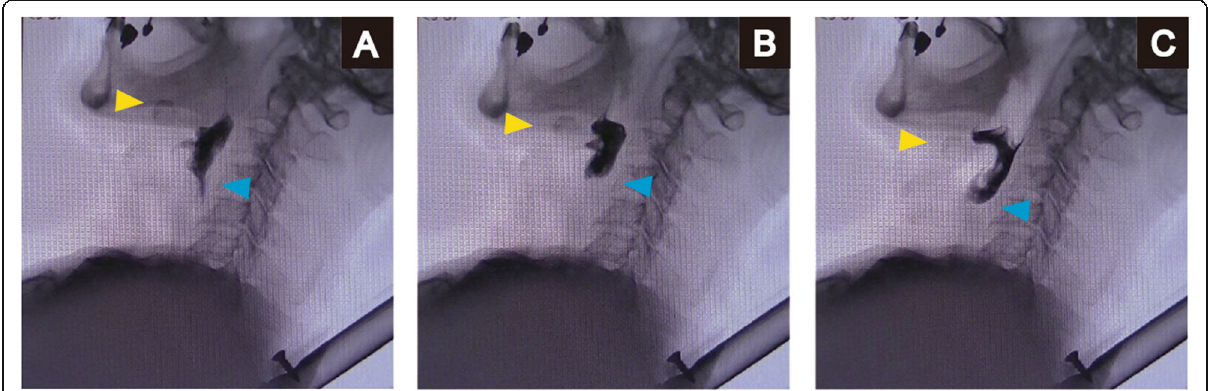
Fig. 2 Swallow functional test before cricopharyngeal myotomy. a Laryngeal penetration occurred during laryngeal elevation in the pharyngeal phase. b The bolus did not pass entirely through the upper esophageal sphincter in the esophageal phase. c Breathing was reinitiated with a massive amount of pharyngeal residue. Yellow arrow; Hyoid bone, Blue arrow; Esophageal